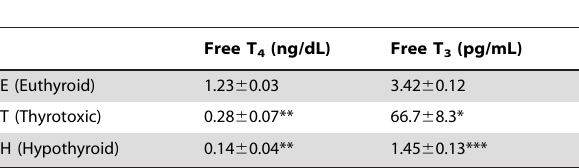
Table 1. Free T 4 and free T 3 levels in each thyroid